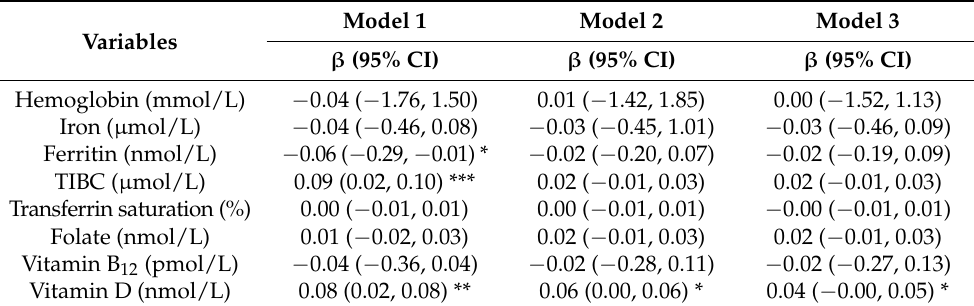
Table 3. The association of plant-based dietary pattern with anemia-related biochemical variables in serum evaluated by the generalized linear regression analysis 1 .